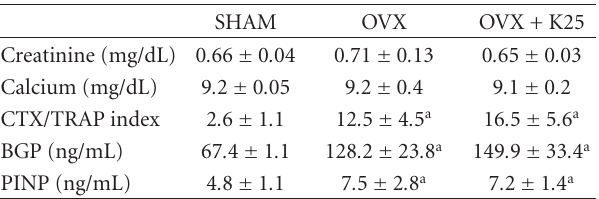
Table 1: Creatinine, calcium, CTX/TRAP index, BGP, and PINP serum levels in female Wistar rats at the end of the study. Six- month-old rats at the beginning of the study were ovariectomized (OVX) or sham-operated (SHAM) and randomized in the fol- lowing groups: SHAM group (SHAM) treated with vehicle for 3 months; ovariectomized group (OVX) treated also with vehicle for 3 months; ovariectomized group treated with Kalsis at a dose